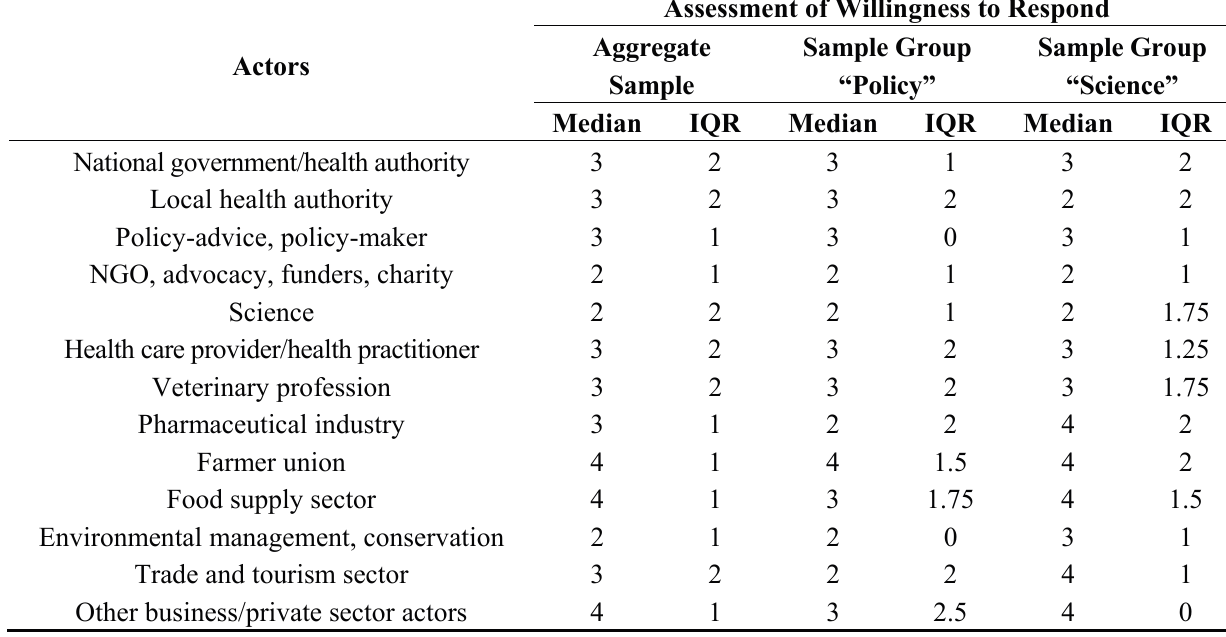
Table 4. Assessment of the willingness to respond of the actors, by the aggregate sample and the two sample groups “Policy” and “Science”.